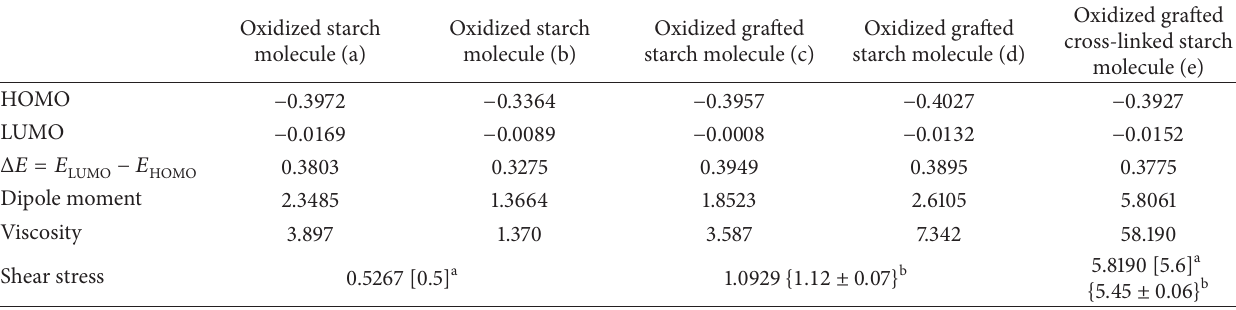
Figure2:TherelationshipbetweenMSDandtimecorrespondingtoannealedamorphouscellembracedfiveoxygenmoleculesintenoxidized modified starch molecules. (a) and (b) are cases of the oxidized starch molecules, respectively; (c) and (d) are cases of the oxidized grafted starch molecules, respectively; and (e) is case of the oxidized grafted cross-linked starch molecule. Table 1: Orbital energies (a.u.), dipole moment (D), viscosity (MPas), and shear stress (MPa) of the oxidized modified starch